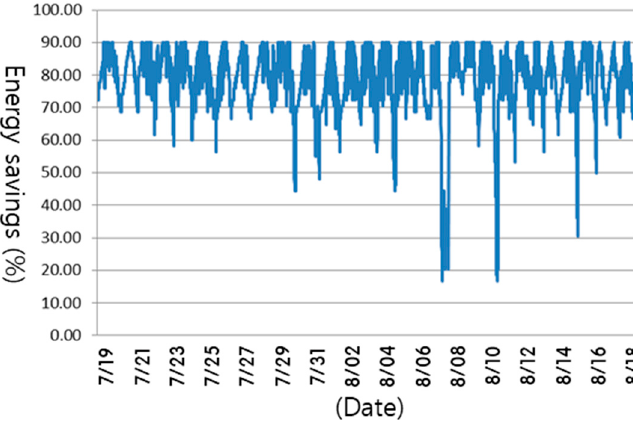
Figure 20. Daily results for the lighting energy-savings ratio.